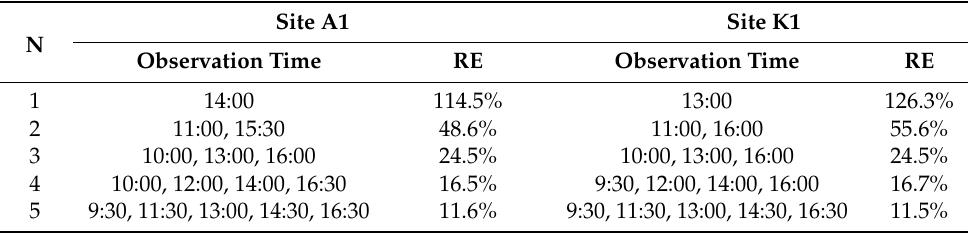
the relative errors remained at about the 10% level. Table 4. Relative errors (RE, %) of the suspended solids (SS) estimation associated with number of observations (N) and corresponding